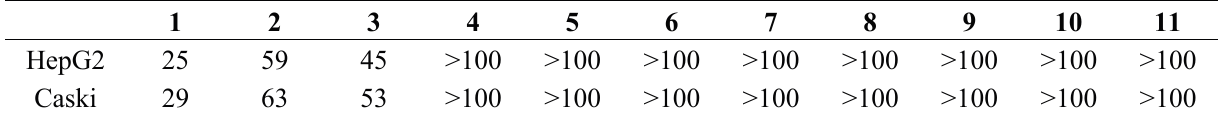
a Results are expressed as IC 50 values in μ M. An average value of three independent experiments is reported. Hep-G2 and Caski are human liver cancer cell line and human cervical cancer cell line,